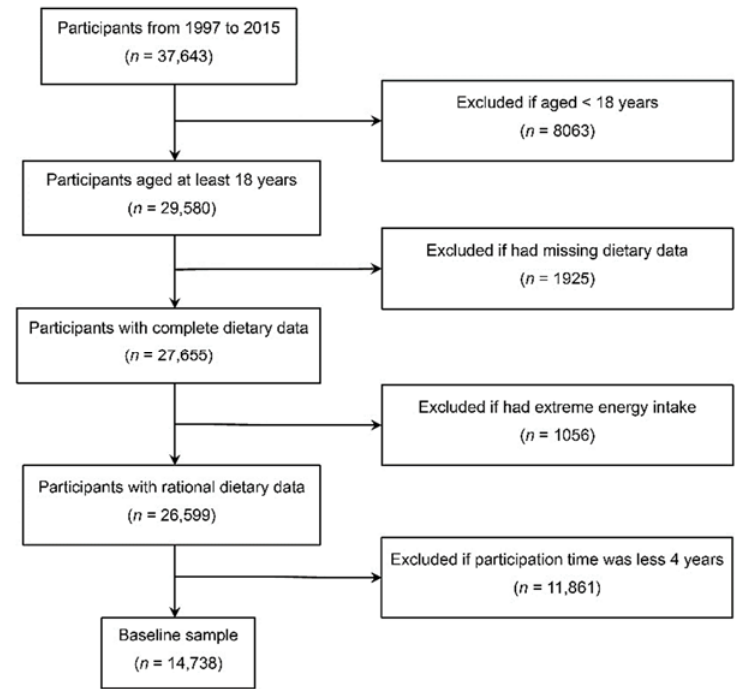
Figure 1. Flow chart of sample selection.